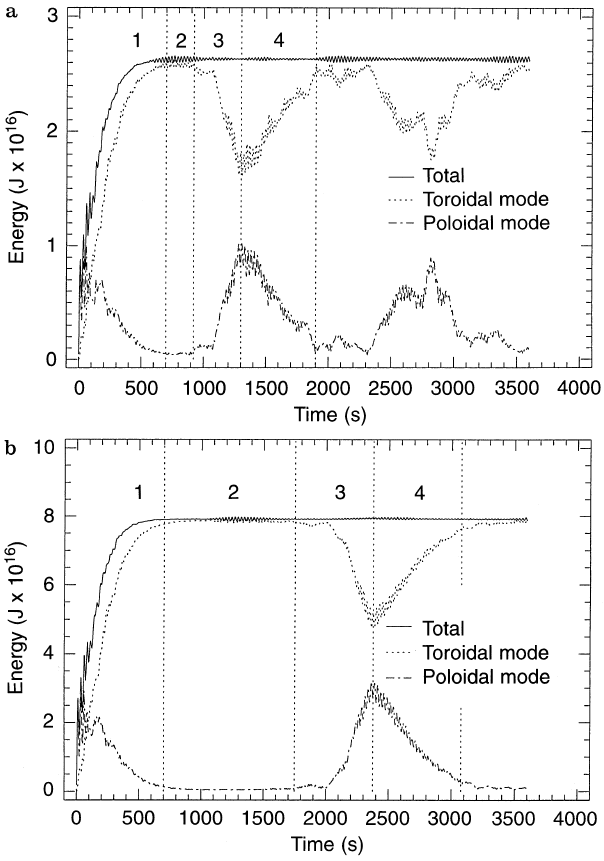
Fig. 3. The energy density profile of the toroidal mode for the high resolution grid ( solid line ), the low resolution grid ( dotted line ) and the poloidal mode ( dashed line ) over the radial distance, integrated over each magnetic shell and averaged over the total simulation time. Note the logarithmic scale